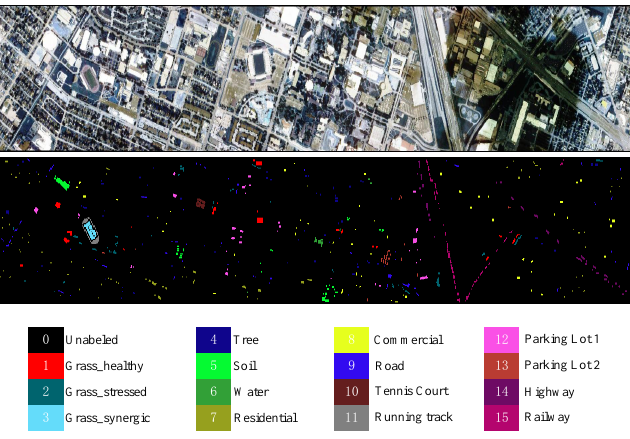
Figure 8. Ground truth map, pseudocolor images, and available samples of Houston